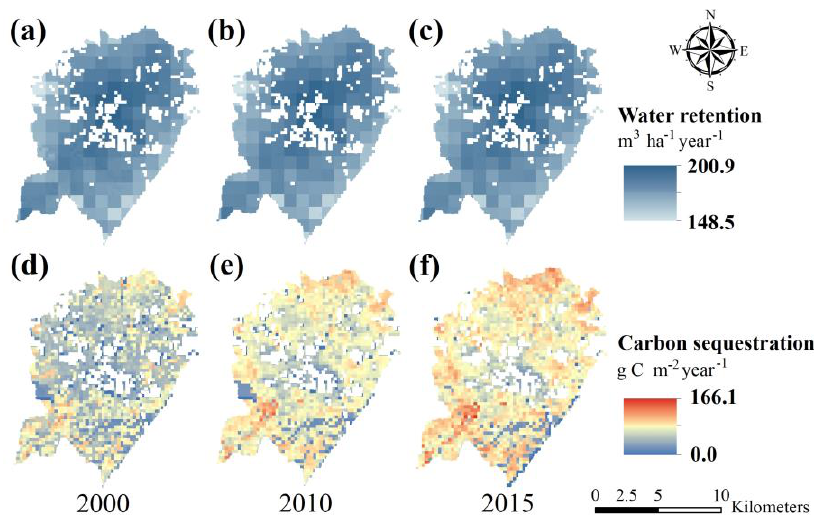
Figure 2. Spatial distribution of the water retention and carbon sequestration in the Huangshan UNESCO Global Geopark, showing water retention for 2000 ( a ), 2010 ( b ), and 2015 ( c ) and carbon sequestration for 2000 ( d ), 2010 ( e ), and 2015 ( f ). Table 3. Area statistics of ecosystem function changes in the Huangshan UNESCO Global Geopark.